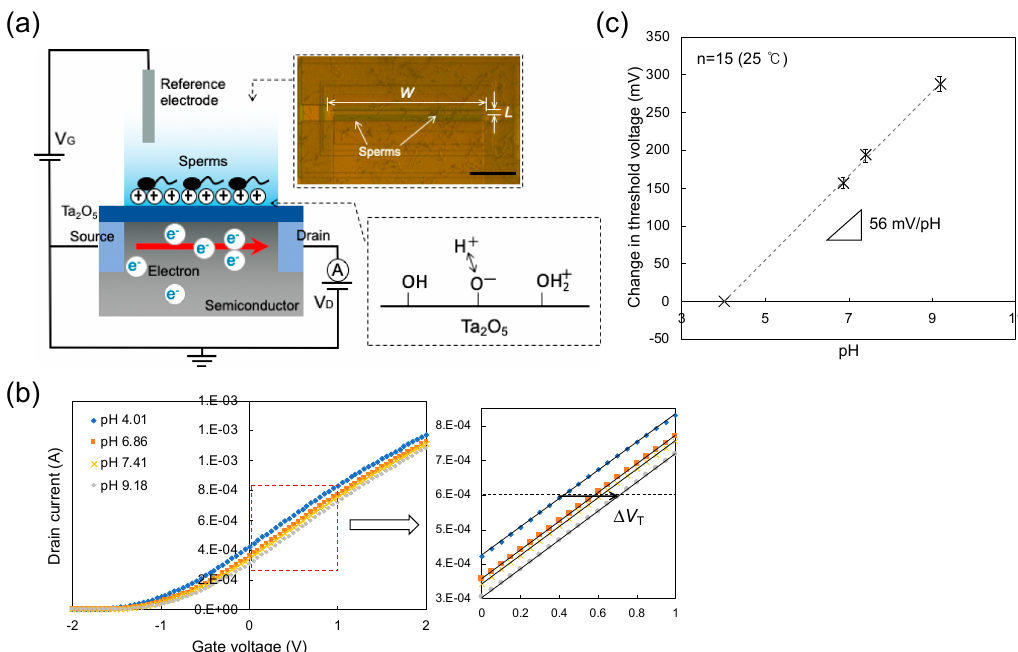
Figure 1. ( a ) Conceptual structure of sperm-cultured gate ISFET sensor for electrical measurements. The channel was designed to have a width ( W ) and length ( L ) of 340 and 10 µ m, respectively. Scale bar = 100 µ m. Hydroxy groups at the oxide membrane in a solution exhibit the equilibrium reaction with hydrogen ions. ( b ) V G – I D electrical characteristic of one of the ISFET sensors used in this study. The shift in V G at a constant I D of 1 mA was estimated as the change in V T when the pH was changed from a pH of 4.01 to 9.18. ( c ) Calibration curve, which was analyzed based on the data shown in (b). The pH sensitivity of this ISFET sensor was about 56 mV / pH, which almost showed a Nernstian response at 25 °C. V G at a pH of 4.01 was offset to 0.